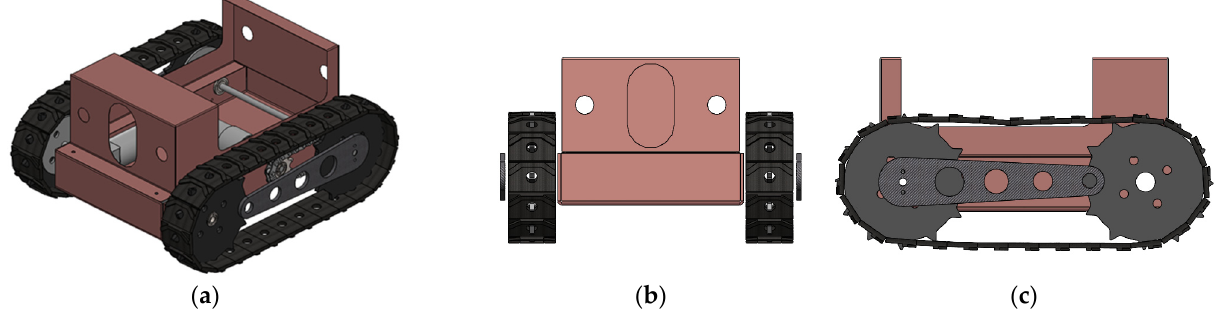
Figure 1. 3D model of the hybrid robot: ( a ) 3D view; ( b ) front view; ( c ) side view.